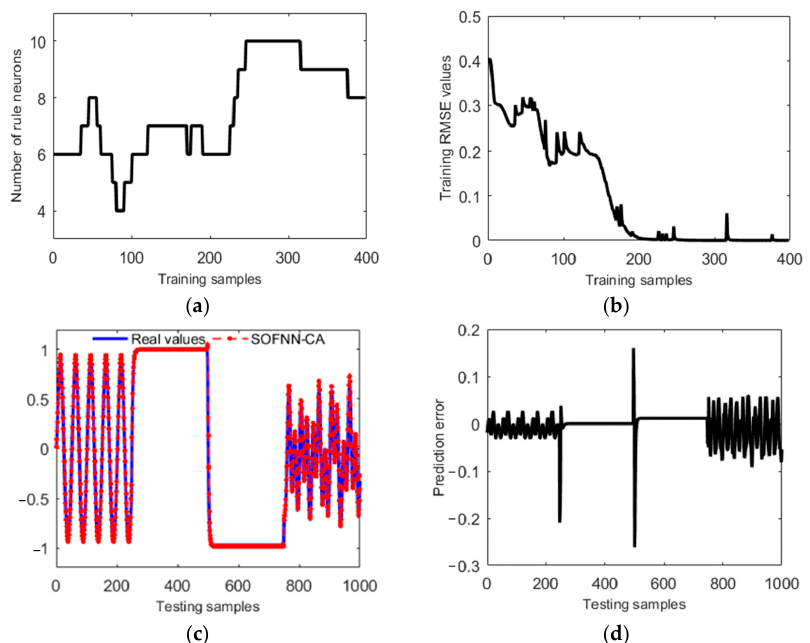
Figure 9. ( a ) Training neuron change plot; ( b ) training RMSE plot; ( c ) test result plot; ( d ) test error plot. Table 2. Comparison results of different methods for identifying nonlinear